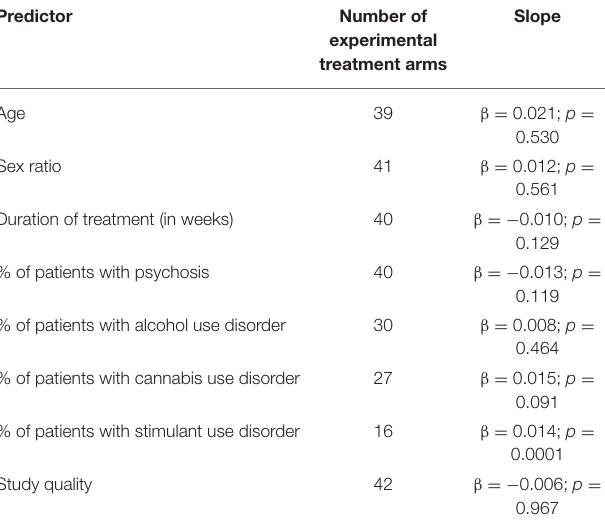
TABLE 3 | Predictors of drop-out rates for experimental